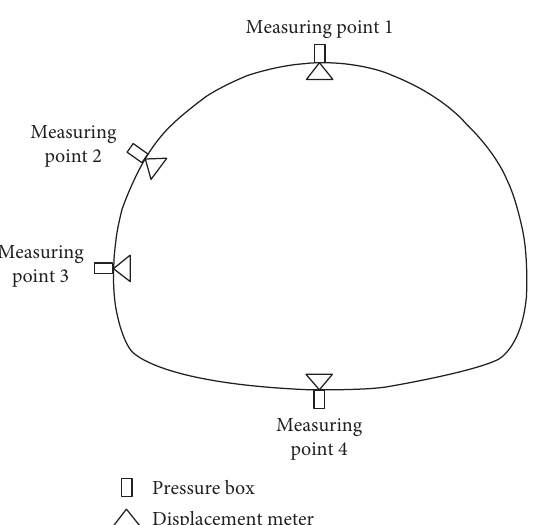
Figure 7: Arrangement of measuring point.